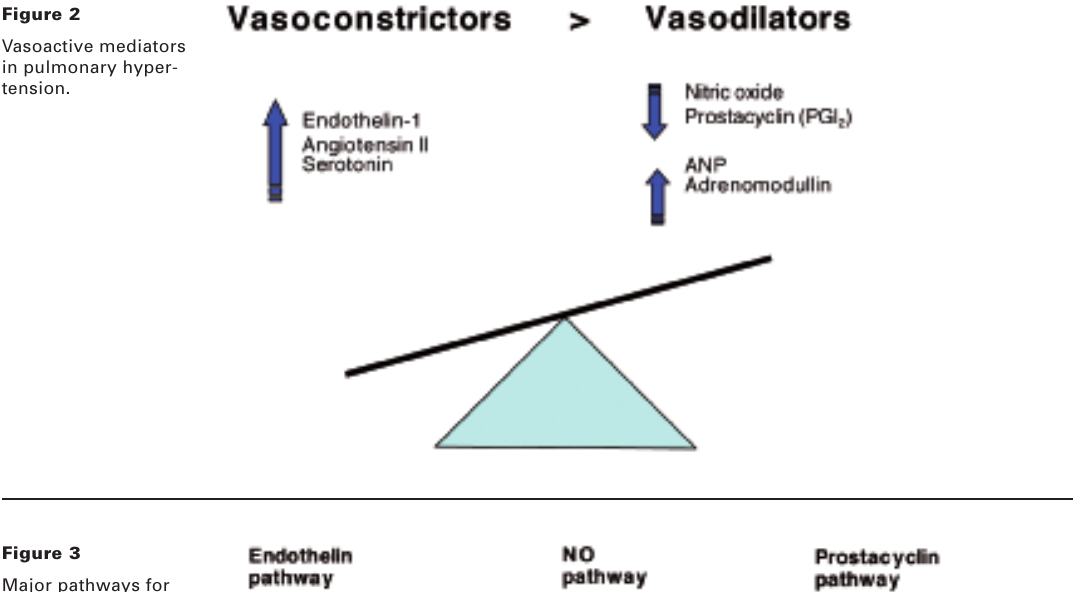
Figure 3 Major pathways for maintenance of